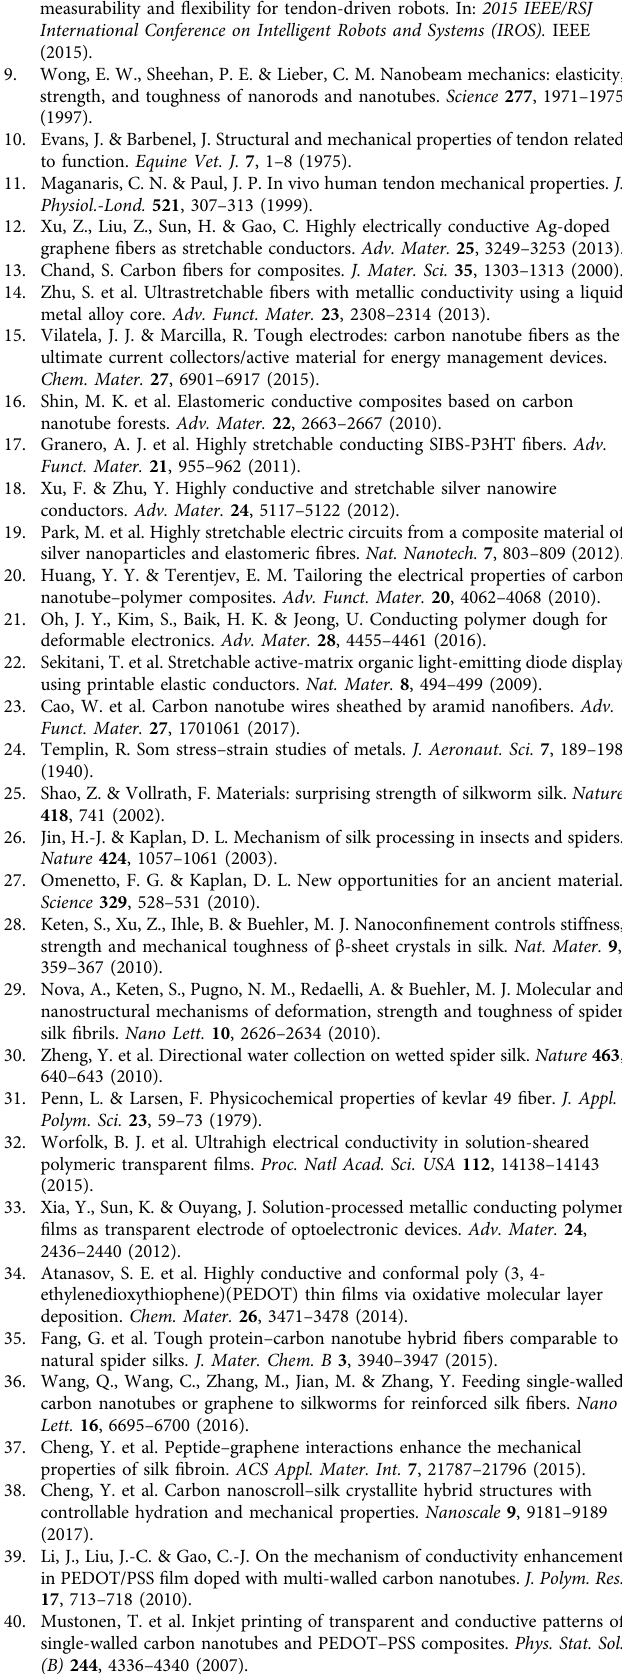
Table 1 DPD parameters for the CG